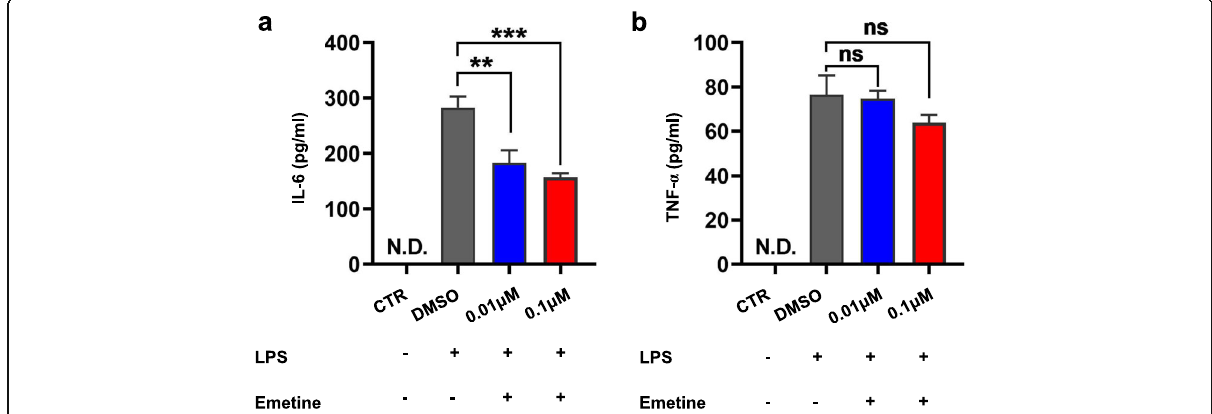
Fig. 2 Anti-inflamatory effect of Emetine. a Quantification of protein levels of IL-6 and b TNF- α in cultural supernatant from M1 macrophages after treatment with emetine or vehicle for 36 h. Results are expressed as means ±S.D. ( n = 3). NS: not significantly different. ** or ***: significantly different from the corresponding control (Ctrl) respectively with p < 0.01 or